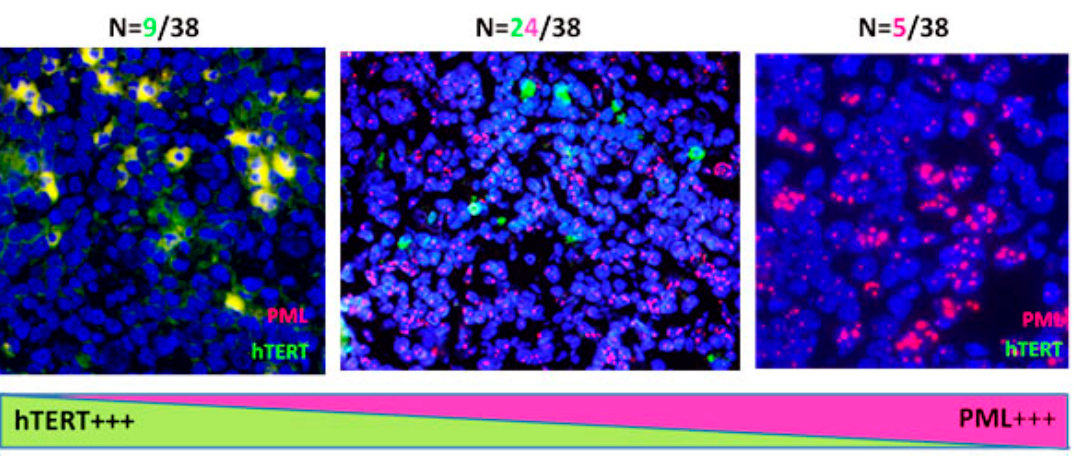
Figure 7. Analysis of the transition between telomerase and ALT in HL lymph nodes from 38 patients. The lymph nodes of nine patients exhibited high levels of telomerase, 24 were characterized by the presence of both telomerase expression and a high level of PML bodies, and five showed a high level of PML bodies with low or undetectable hTERT expression (40× magnification).